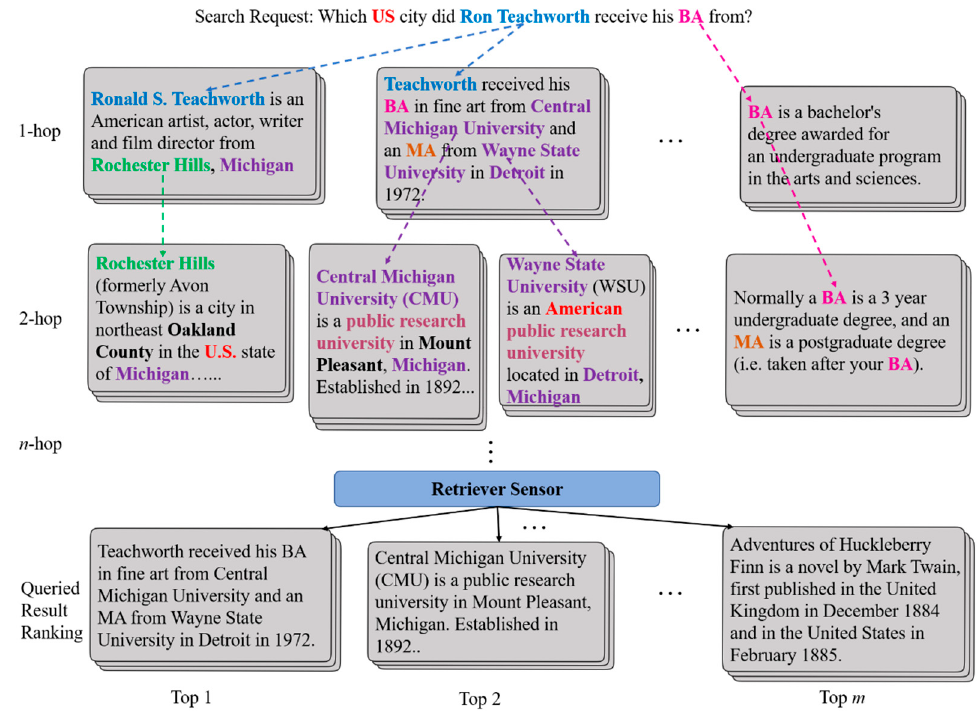
Figure 1. An example of a multi-hop retrieval task. The method in this paper mimics the human reasoning process while searching for information online. The retrieval sensor will finally provide users with reasoning chains, which will help obtain structured retrieval information.